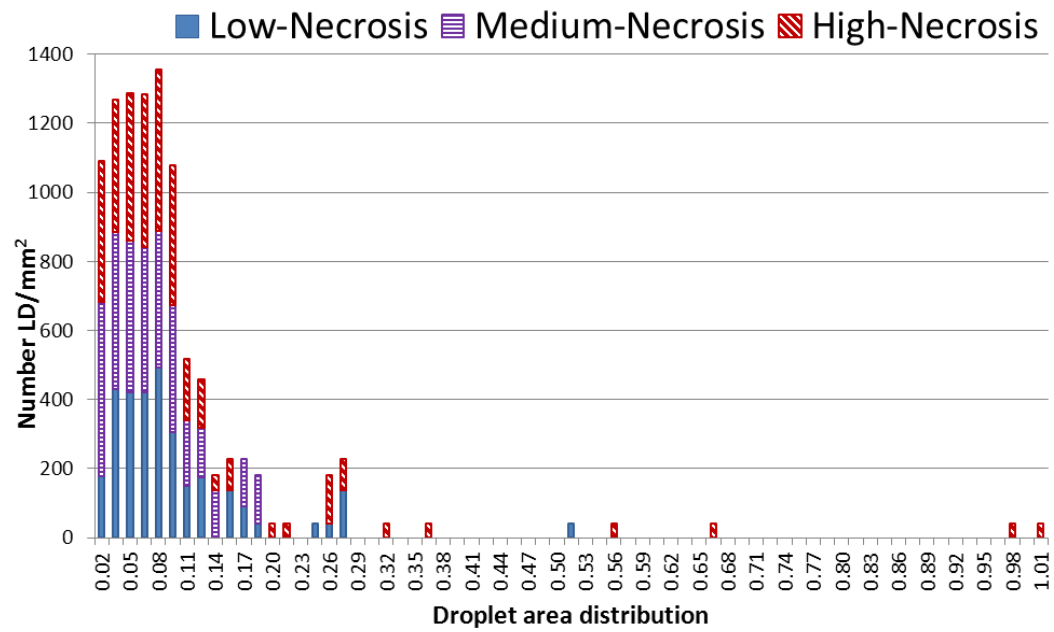
Figure 4. Distribution of lipid droplets for droplet area between 0 and 1.005 µm 2 in bins of 0.015 µm 2 . The x -axis represents droplet area distribution and the y -axis—droplet density (number LD/mm 2 ). The red, purple and blue bars represent the mean number of LD in high (>70%) medium (40%–70%) and low (<40%) necrosis,